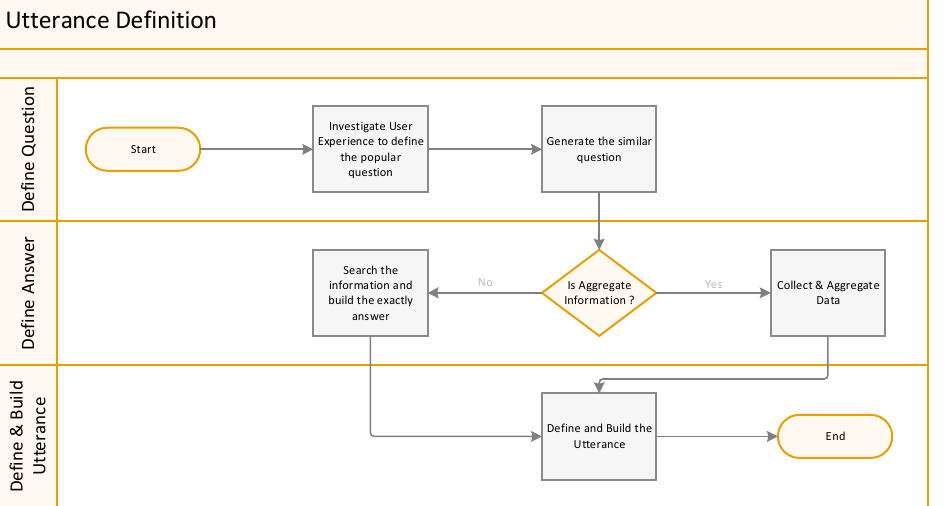
Figure 8. Process of defining Utterance.